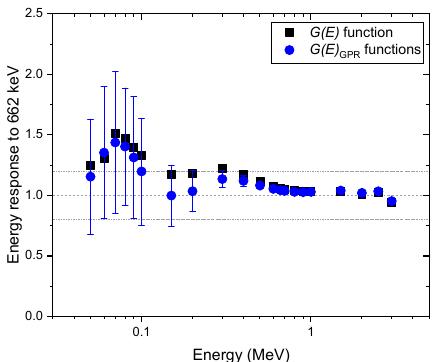
Figure 7. Comparison of energy response normalized to the energy of 622 keV, estimated with G ( E ) functions, and the G ( E ) function for the spectra obtained under the angle of incidence of 45 ° . The error bar shows a 95% confidence interval.